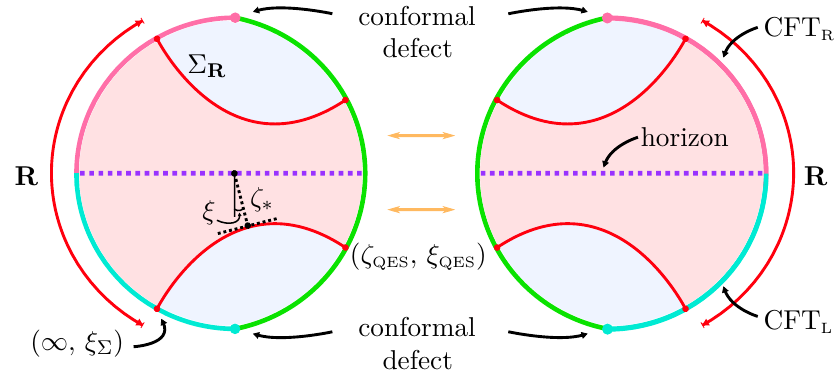
Figure 8. This figure shows the RT surface and various quantities defined in the text for the RT surface in the connected phase. The entangling region R in the boundary is composed of the two regions | χ | > χ Σ (where tan ξ Σ = sinh χ Σ ) in both the left and right CFTs. Note that the right (left) CFT occupies the region on the asymptotic boundary marked in pink (aqua). The conformal defects (i.e. χ = 0 or ξ = 0 and π ) are positioned where the brane (green) reaches these boundary regions.